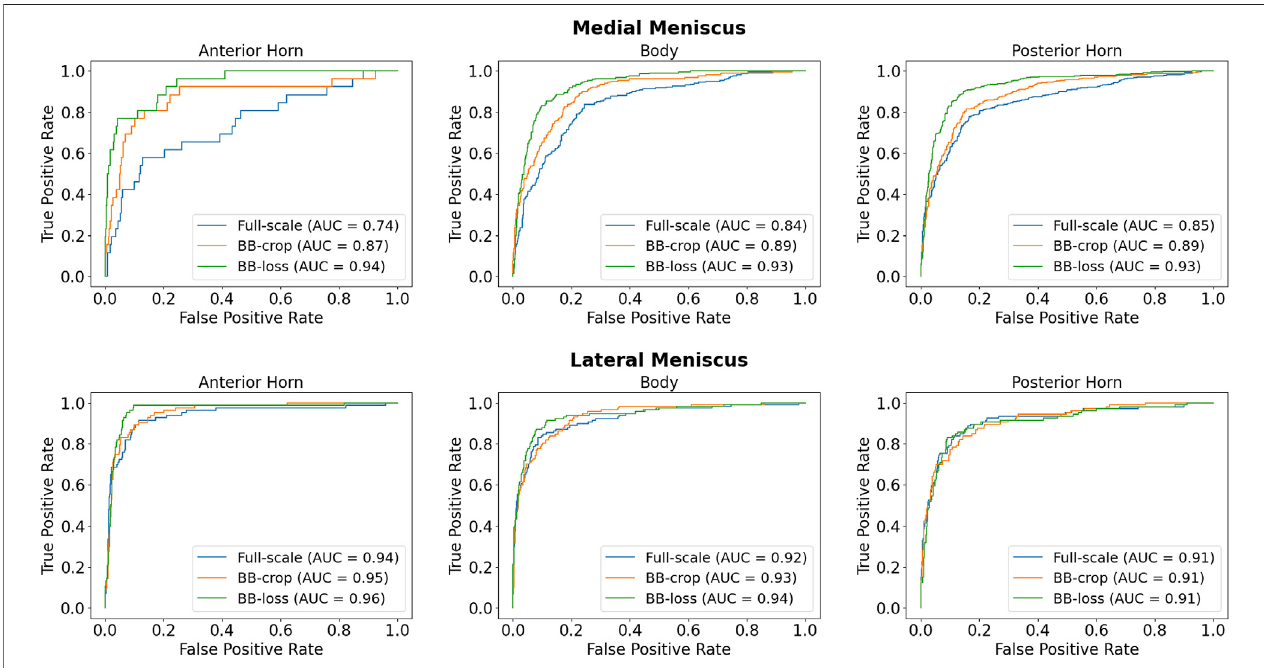
FIGURE 3 | ROC curves for detection of meniscal tears in DESS MRI data.